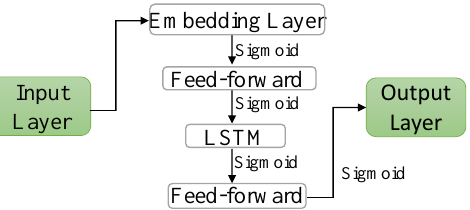
Figure 12. The topology of the deep learning network proposed in